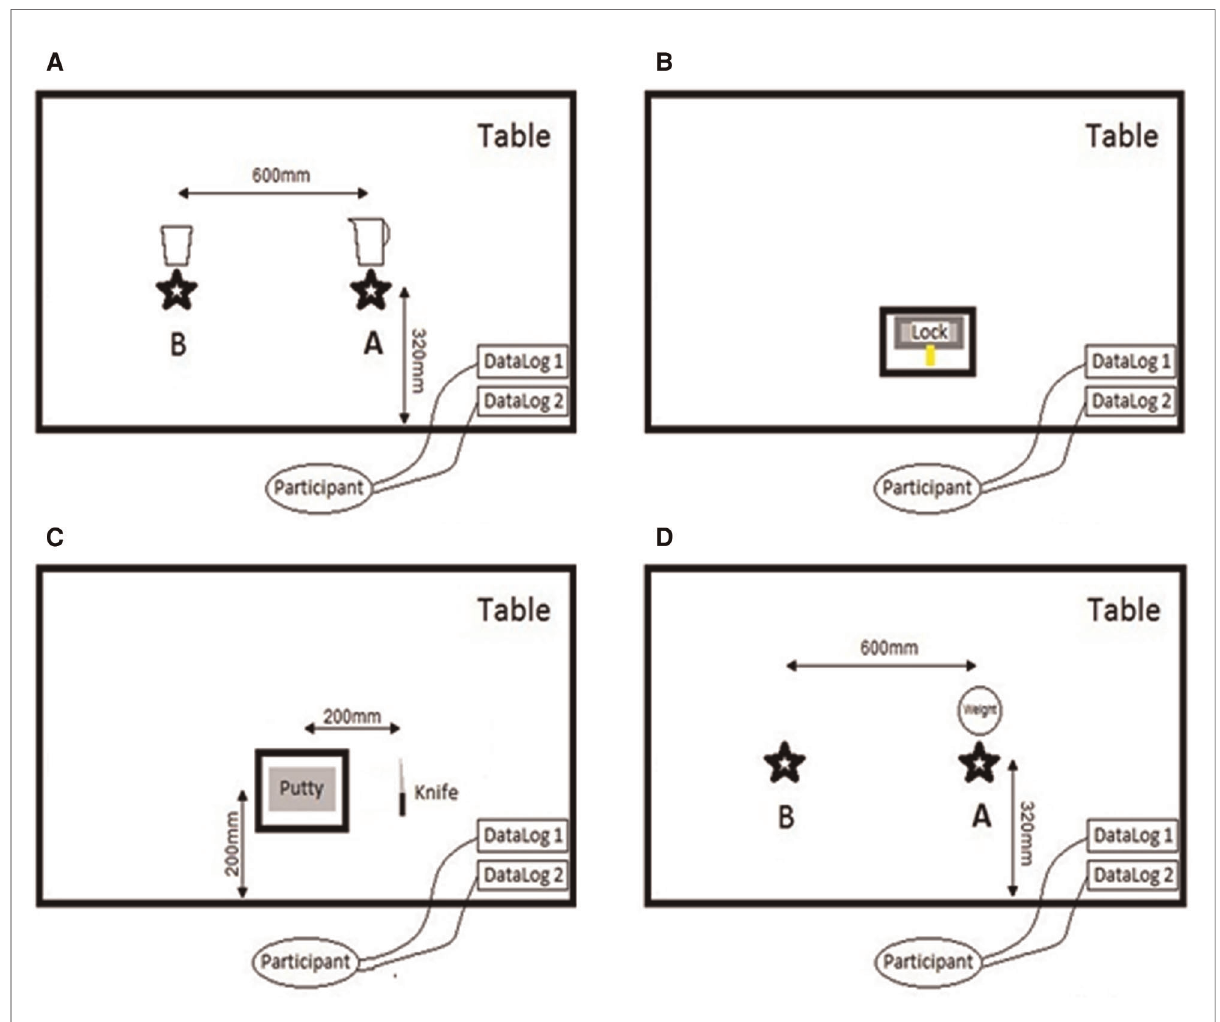
FIGURE 1 Example of a setup for ADL1 ( A ), ADL2 ( B ), ADL3 ( C ), and ADL4 ( D